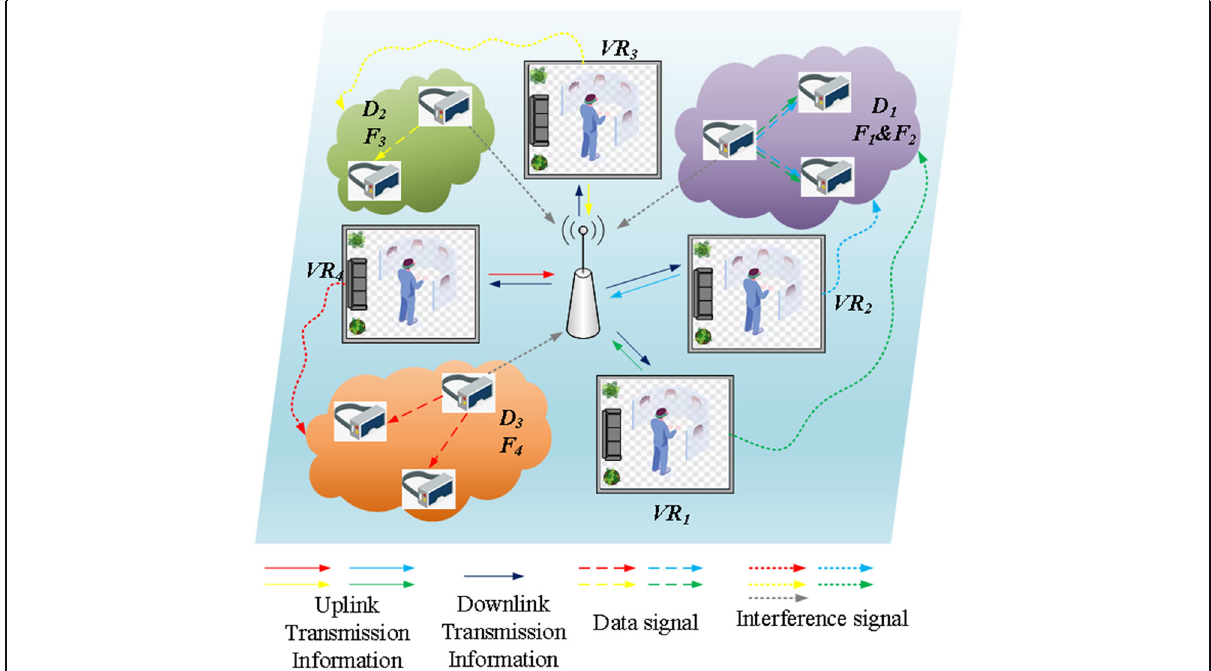
Fig. 1 The system model of VR D2D multicasting clusters